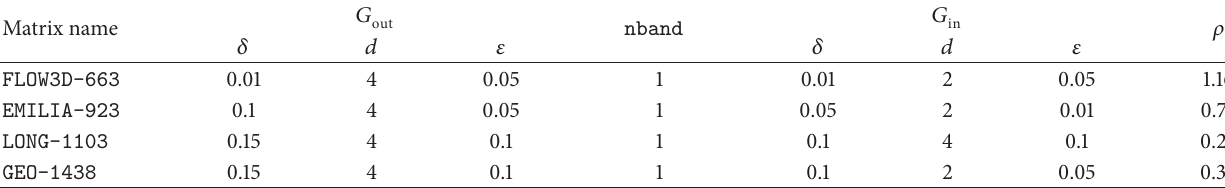
Table 3: RFSAI parameters used for the eigensolution of the four test problems.